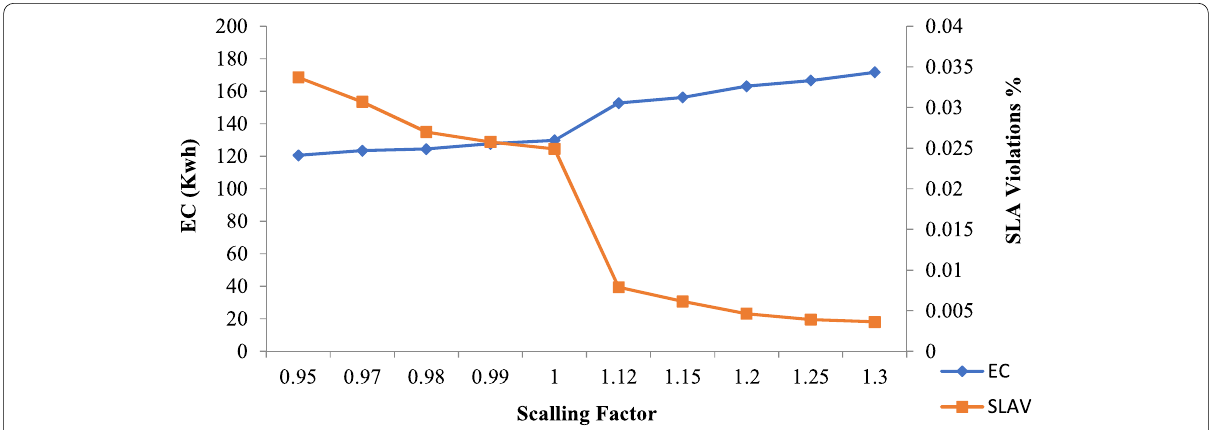
Fig. 2 The output of Energy consumption and SLAV by LrMmt